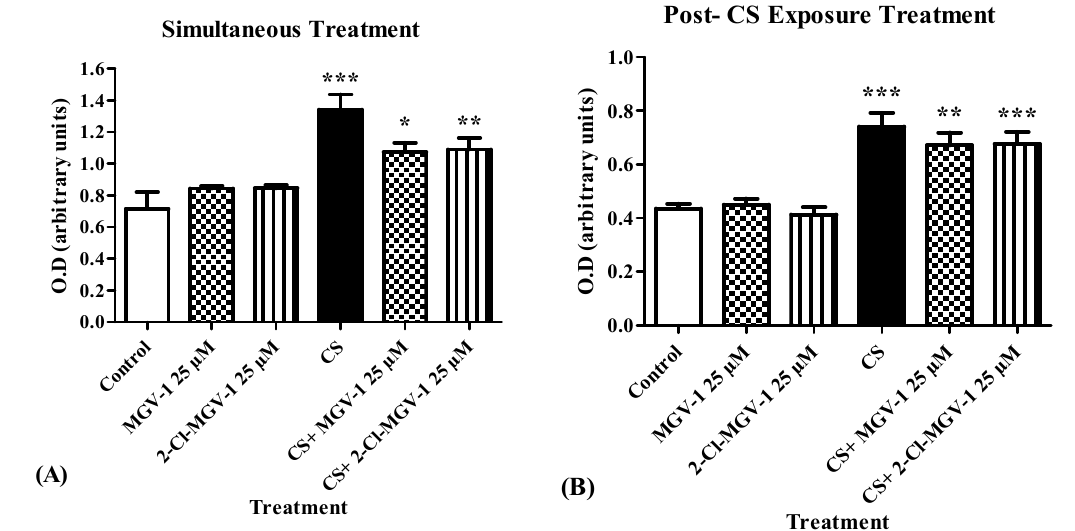
Figure 2. Simultaneous and post-CS exposure treatment with TSPO ligands against CS-induced cytotoxicity in H1299 lung cancer cells. Cytotoxicity levels were elevated significantly following CS exposure, and MGV-1 (25 µM) and 2-Cl-MGV-1 (25 µM) failed to prevent the CS-induced damage when applied as ( A ) simultaneous treatment and ( B ) post-CS exposure treatment. Results are represented as mean ± SEM. * p < 0.05, ** p < 0.01 and *** p < 0.001 vs. control. CS = cigarette smoke.